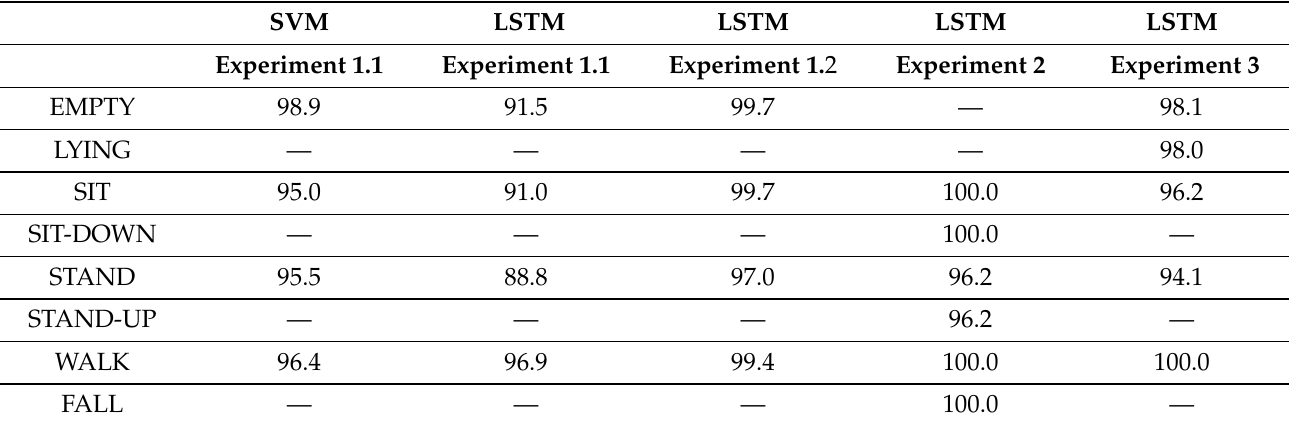
Table 9. Comparison of predicted precision matrix for all